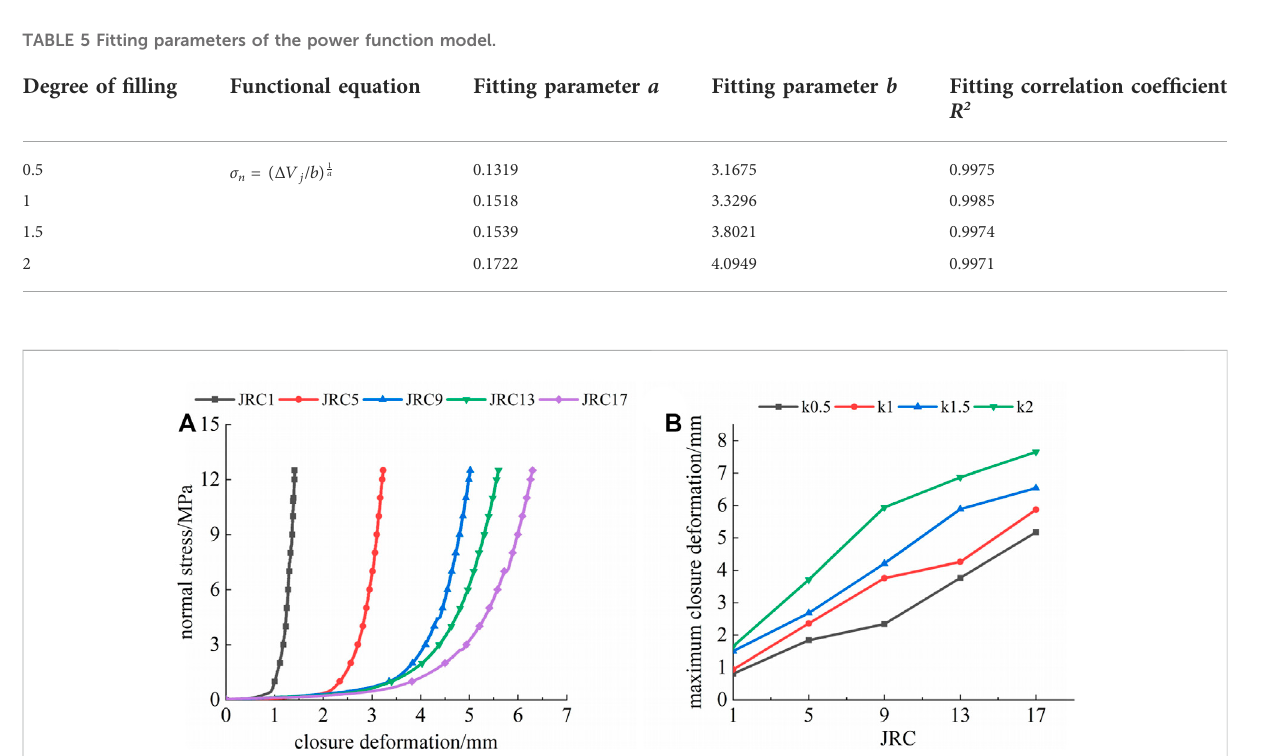
FIGURE 12 Effectofthedegreeofmorphology fl uctuationonthenormalclosuredeformationcharacteristicsof fi lledrockjoints: (A) normalstress-closure deformation curve of a fi lled rock joint (k=2) and (B) maximum closure deformation-JRC curve of a fi lled rock joint.